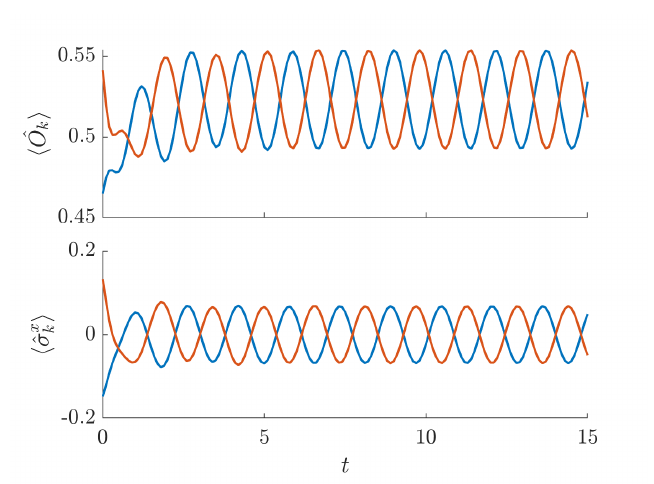
Figure 4: Evolution of the model described in Sec. 6.1 with parameters ∆ = 1, B = 0.5 and γ = 2. The system is initially described by a randomly chosen density matrix. In the top plot we compare a randomly generated Hermitian observable on sites 2 and 3 (blue and red curves respectively). While they oscillate out of phase they have an offset equilibrium value which disrupts the perfect anti-synchronization. In the bottom plot we now compare the σ x observable on each site and see perfect 〉 → 0 as t → ∞ anti-synchronization since 〈 σ z 1